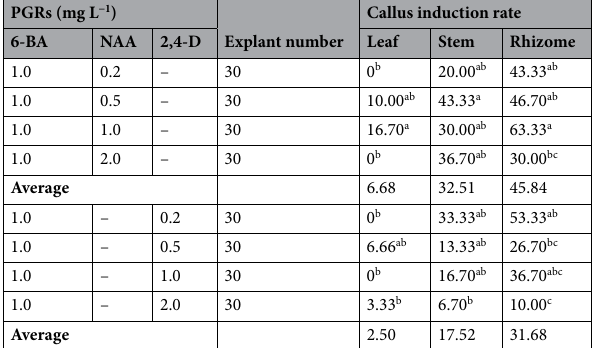
Table 2. Effects of auxin, NAA, and 2,4-D on different explants callus induction rate. Different letters in the same column indicate significant differences between the treatments ( P < 0.05).